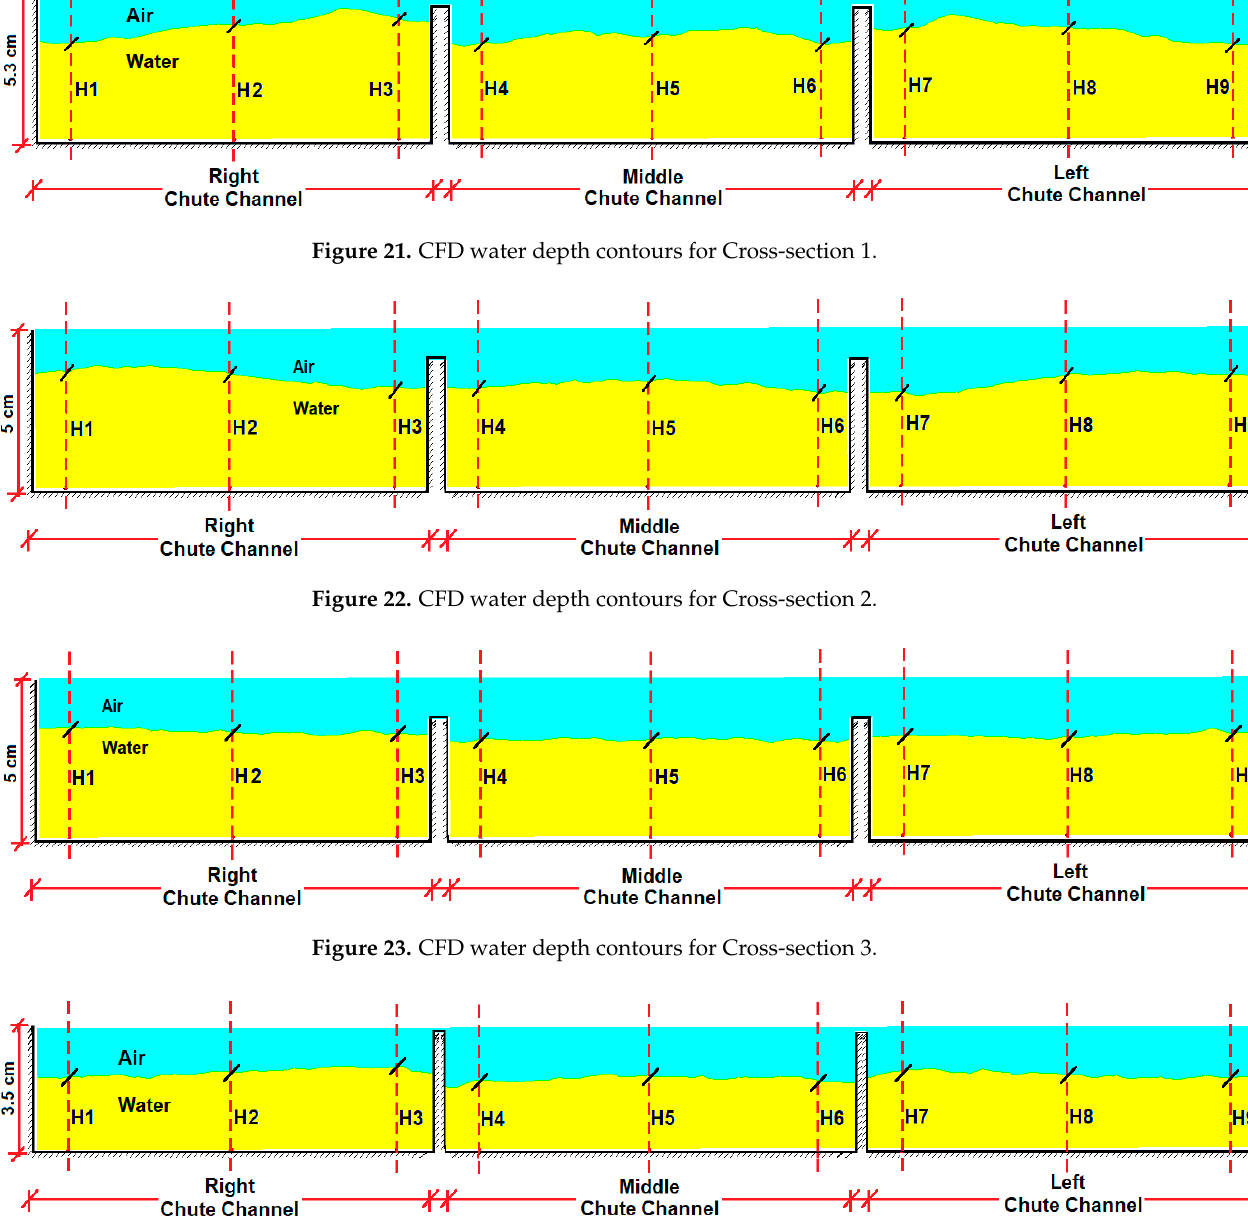
Figure 24. CFD water depth contours for Cross-section 4.